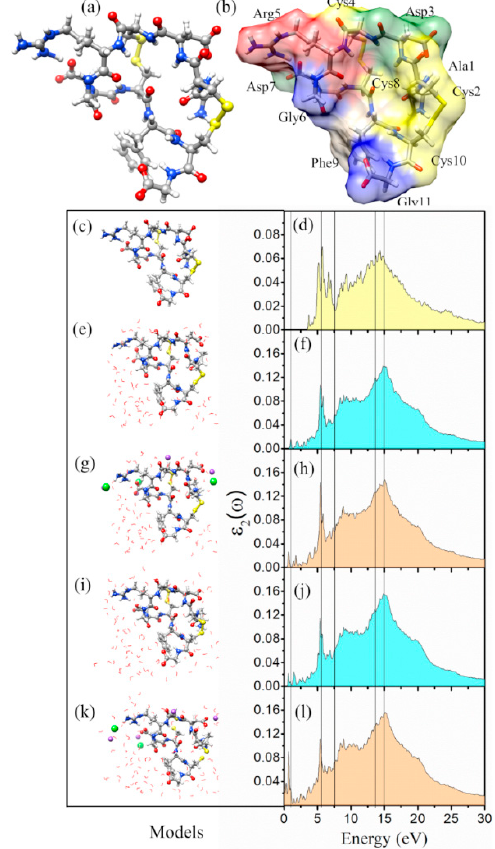
Figure 1. Dry, solvated, and salted models for 1FUV with their ε 2 ( ω ) spectra and ε 1 ( 0 ) values. Ball and stick illustration of ( a , c ) dry 1FUV with ( b ) surface shown with different colors. ε 2 ( ω ) for: ( d ) dry 1FUV; ( f ) 1FUV with 80 H 2 O, ( h ) 1FUV with 80 H 2 O and 0.15 NaCl, ( j ). 1FUV with 100 H 2 O, and ( l ) 1FUV with 100 H 2 O and 0.15 NaCl. The ball and stick figure for respective cases are in ( e , g , i , k ) the left panel. Gray: C, red: O, blue: N, white: H, green: Cl, and purple: